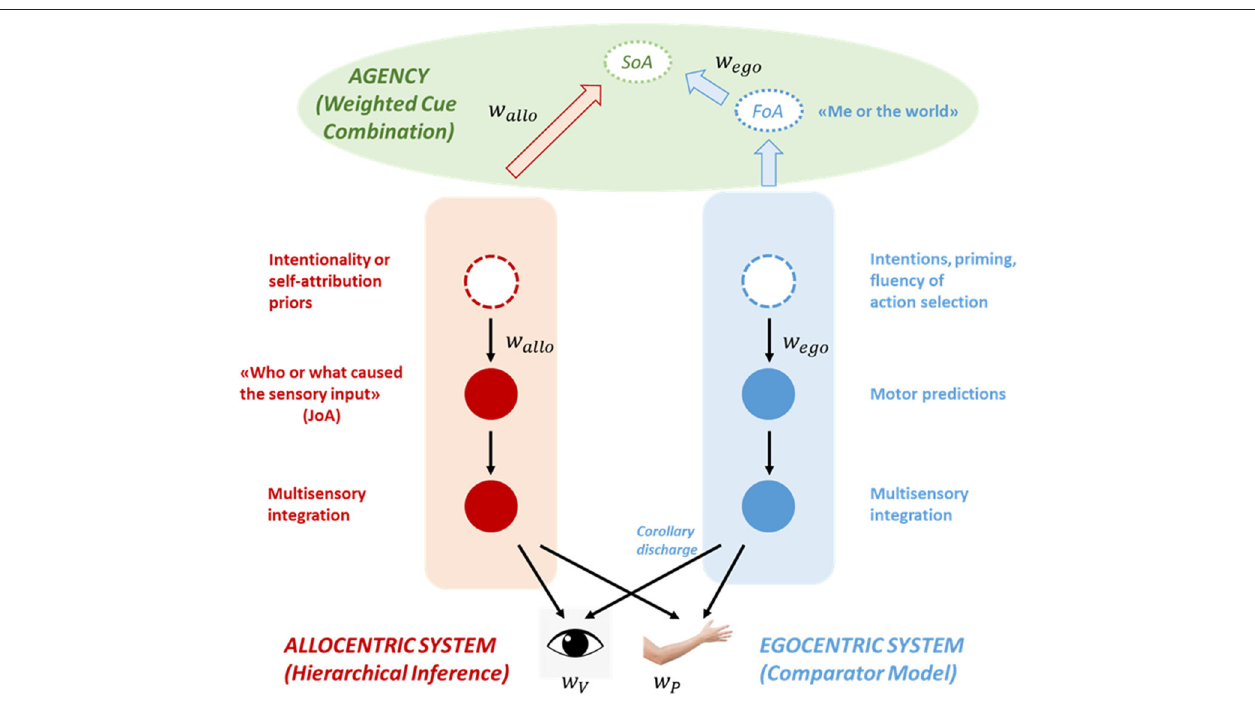
FIGURE 1 | An illustration of the model. The model consists of two hierarchies, an ego-centric and an allo-centric system, that operate in tandem and interact at the sensory level. The ego-centric system (in blue) is part of a sensorimotor loop and implements a comparator model. A copy of the motor command (transformed via a forward model into a motor prediction about the sensory outcomes of the action) is sent to the sensory areas where it suppresses self-generated (i.e., predictable) inputs. Motor predictions can be modulated by higher-level factors such as intentions or the fluency of action selection. The allo-centric system (in red) represents generative causal models of the world, including the self among the potential causes. According to predictive coding, allo-centric predictions (like motor predictions) explain away predictable inputs, but unlike the ego-centric system those inputs are not necessarily self-generated. Allo-centric predictions are also modulated by higher-level priors such as an intentionality or a self-attribution bias. Both types of predictions and the sensory inputs are weighted according to their reliability ( w ego , w allo , and w V , w P , respectively). Crucially, both systems make inferences about different levels of agency. The ego-centric system implements a private mechanism that makes a self-world distinction and gives rise to a feeling of agency (FoA) when motor predictions and inputs are in good match. The allo-centric system on the other hand generates judgments of agency (JoA) based on generic inferential mechanisms, by comparing multiple hypothesis about the cause of a certain outcome (“Me” vs. “External agent” vs. “External non-agentic cause” vs…). The different components of agency are then fed-forward to an agency-attribution system (in green), where they are combined according to a weighted cue combination mechanism that gives rise to a higher-level sense of agency